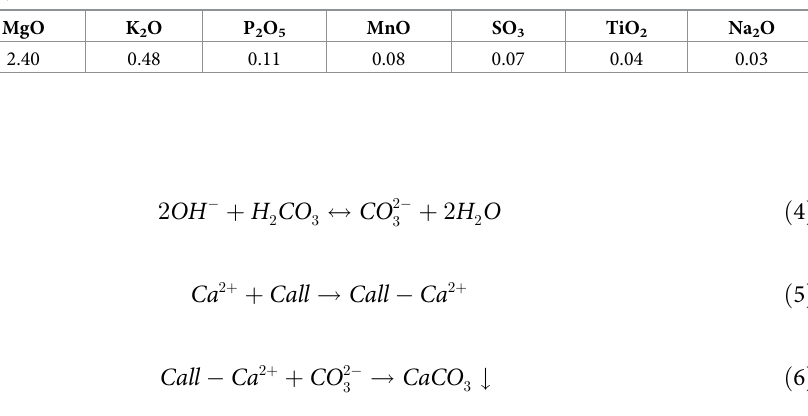
Table 1. Main chemical composition and content in tailings (wt%).